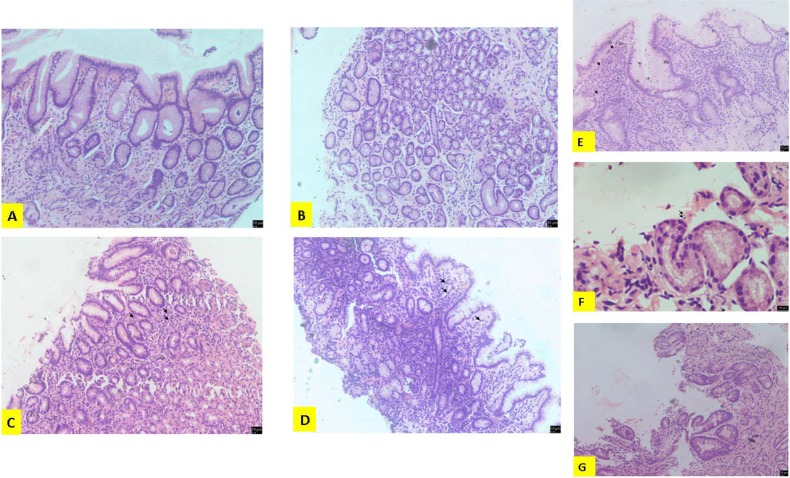
Hematoxylin & Eosin (H & E) histopathological investigations on gastric antrum and corpus mucosal tissues of individuals with different gastroduodenal diseases and gastric cancer (GC) positive and negative for H. pylori infection.(A & B) Antrum tissue showing chronic changes with mild glandular atrophy (Magnification: 100X). (C) Corpus tissue showing signs of chronic active gastritis with mild chronic inflammatory activity and moderate active inflammation. There is moderate infiltration of neutrophils (arrow) (Magnification: 100X). (D) Antrum tissue showing chronic active gastritis with marked chronic inflammatory activity. There is marked infiltration of plasma cells and lymphocytes (arrow) (Magnification: 100X). (E) Antrum tissues showing chronic active gastritis with marked chronic inflammatory activity and superimposed moderate active inflammation. There is moderate glandular atrophy and intestinal metaplasia. There is infiltration of eosinophils (arrow) (Magnification: 100X). (F) Antrum tissue showing marked intestinal metaplasia with goblet cell change (Magnification: 100X). (G) Gastric tissue with H. pylori (arrow) (Magnification: 400X).